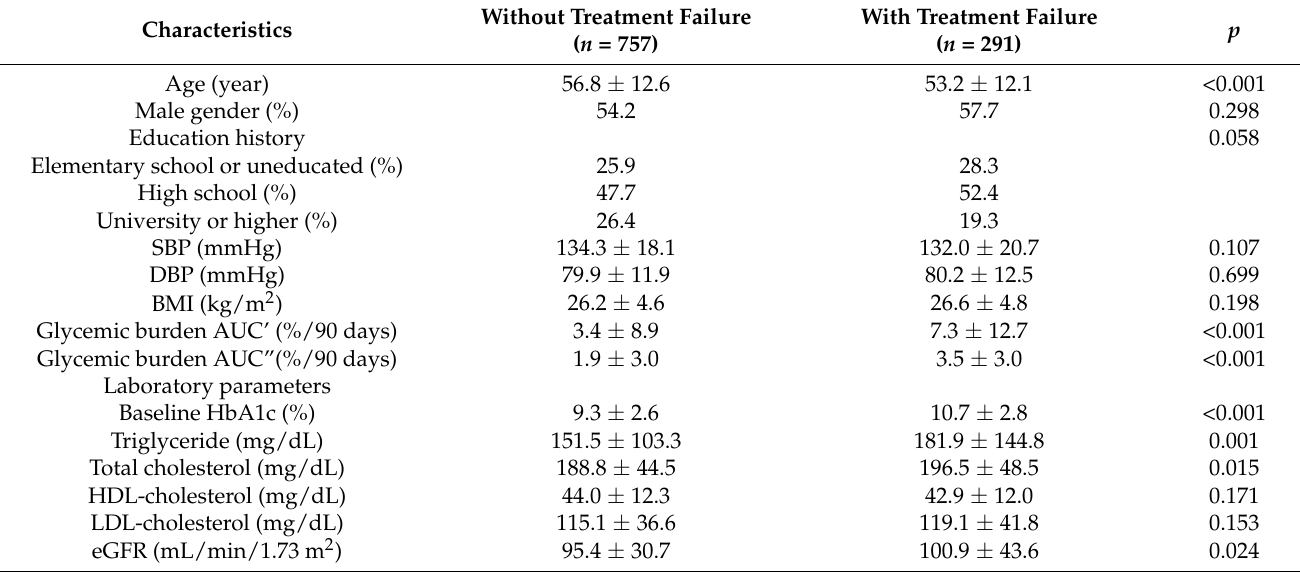
Table 1. Comparison of clinical characteristics among participants, according to without or with treatment